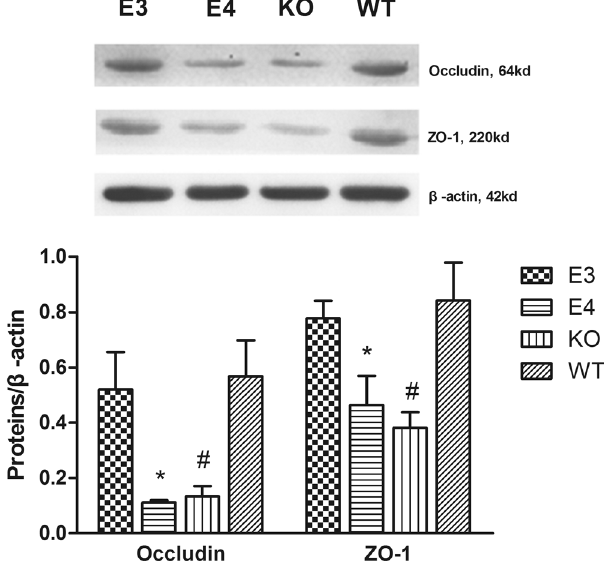
Figure 4. The Western blot results showed that Occludin and ZO-1 contents in the WT mice were significantly higher than those in the E4 and KO mice, and higher expressions were observed in E3 mice than in E4 mice. ( * P < 0.05 vs E3 mice and P < 0.01 vs WT mice; # P < 0.01 vs WT mice. N = 8). The data are presented as the mean ±